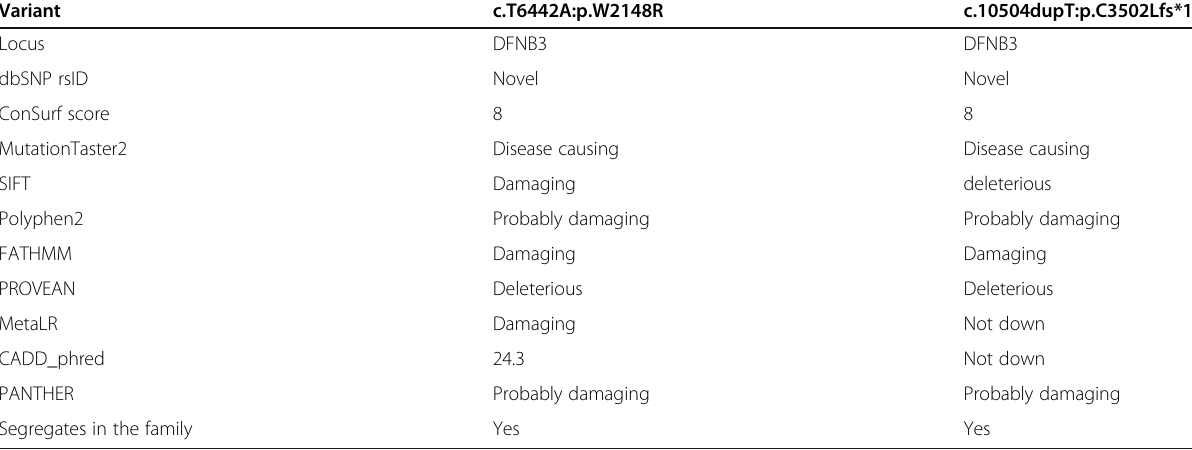
Table 1 In Silico and Bioinformatics Analysis of the Variants